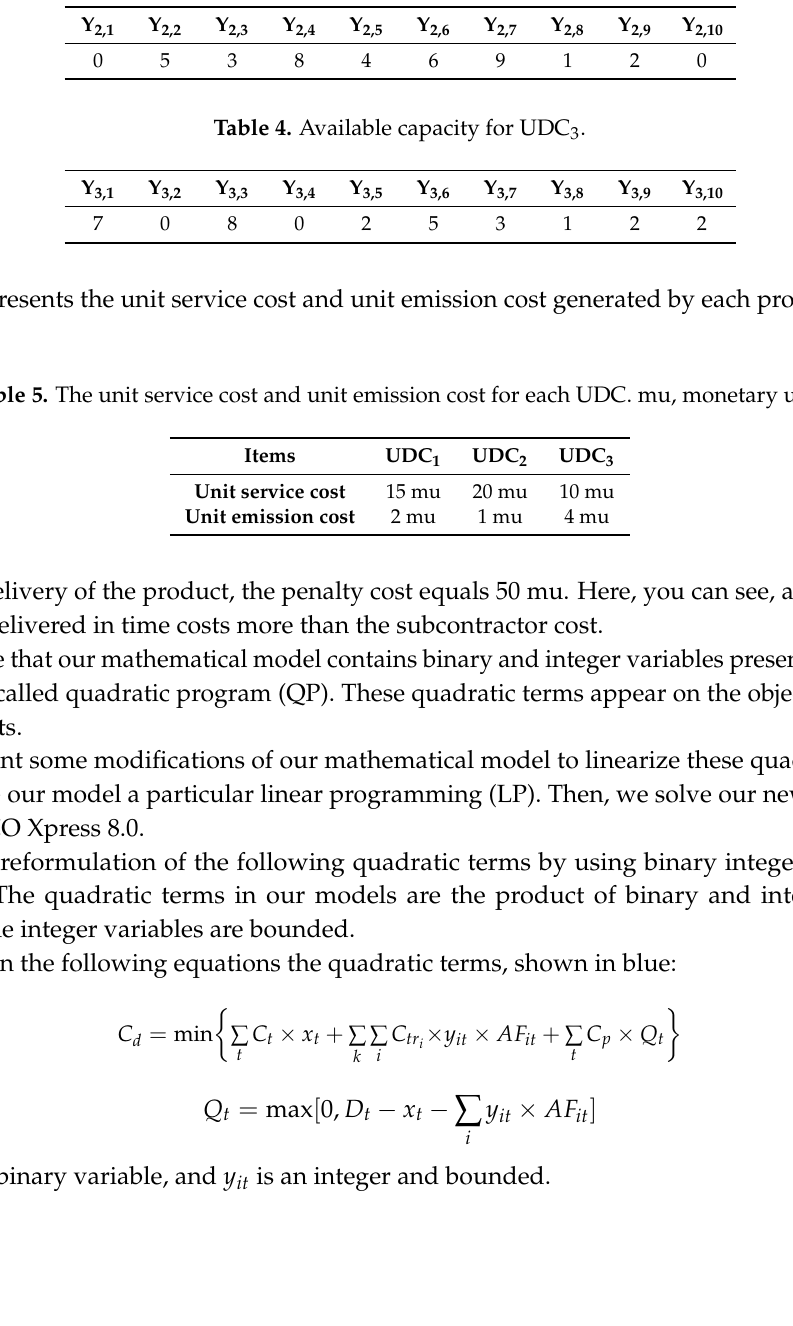
Table 3. Available capacity for UDC 2 .